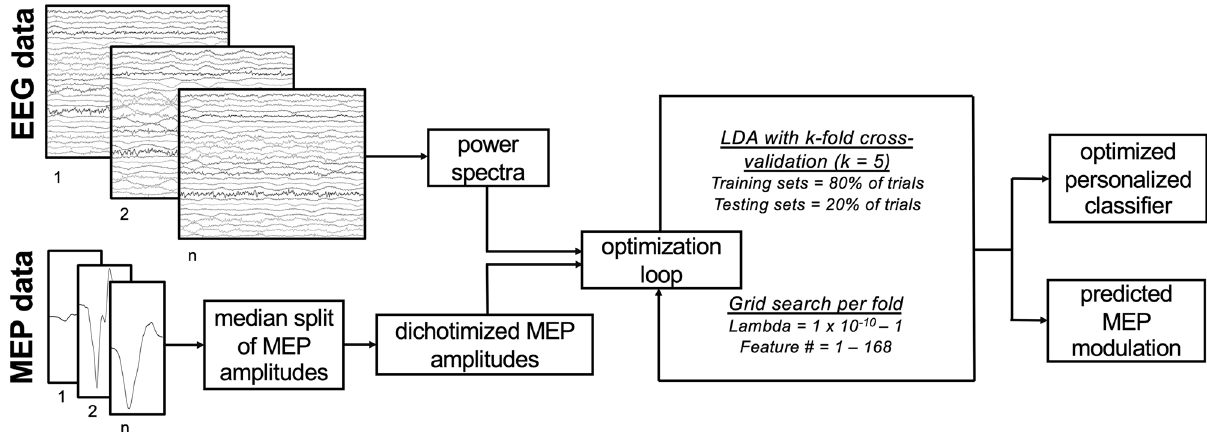
Figure 1. Analytical procedures used to optimize each participant’s personalized classifier. Raw EEG data undergo spectral analysis. MEP amplitudes are calculated and divided into small and large MEPs via median split. Afterwards, fivefold cross-validated grid search is performed by fitting LDA classifiers for 100 different lambda values and 168 different feature numbers, with features added in order of importance. Then, each participant’s best performing cross-validated classifier is selected and the predicted MEP amplitude modulation is calculated using the true MEP amplitudes for each of the predicted classes obtained during cross-validation. For each participant, 16,800 classifiers are trained and tested during the optimization and classification loop, which takes ~ 4 min on a standard laptop